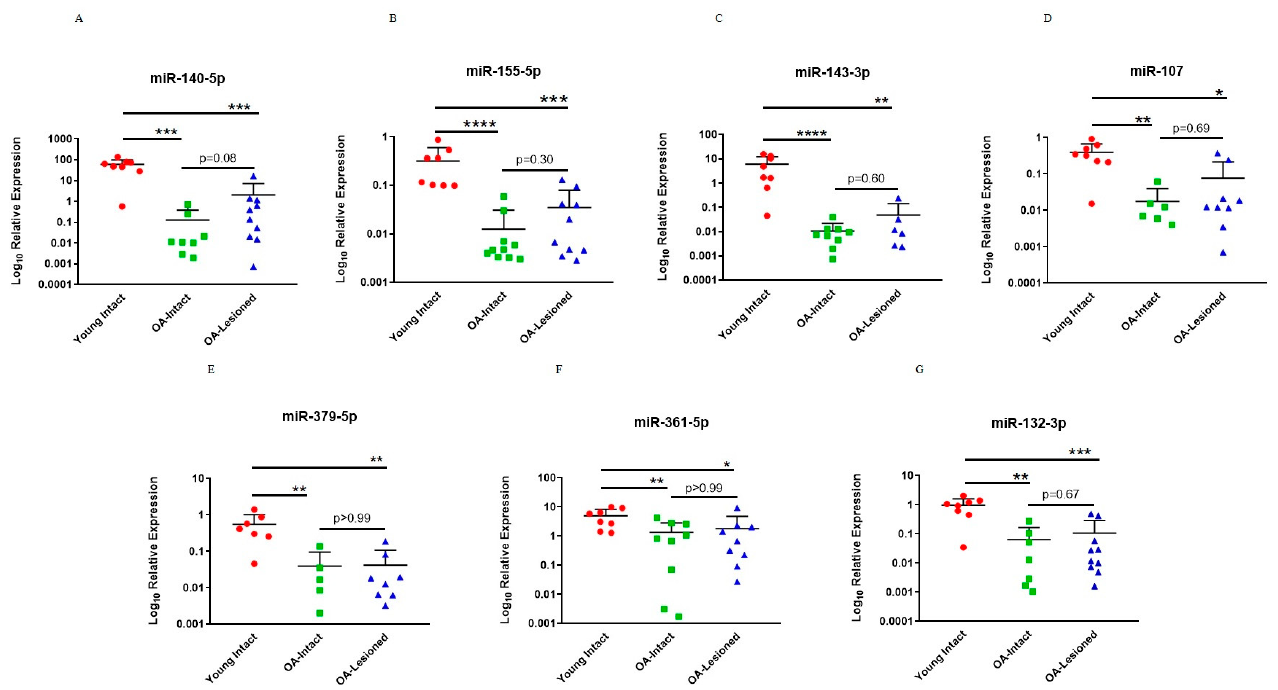
Figure 3. qPCR validation of selected DE miRNAs from the dependent cohort. Seven miRNAs; ( A ) miR-140-5p, ( B ) miR-155-5p, ( C ) miR-143-3p, ( D ) miR-107, ( E ) miR-379-5p, ( F ) miR-361-5p and ( G ) miR-132-3p, which were DE in microarray analysis were selected for validation with qPCR in the same samples. n = 5–10 samples/group. Y axis represents log-transformed expression relative to miR-6786-5p. Statistical analysis was undertaken using a Mann–Whitney test in GraphPad Prism (Version 8.0.1). Data are represented as mean + SD. Red: Young group, Green: OA-Intact group, Blue: OA-Lesioned group. p values < 0.05 were considered significant. *: p < 0.05, **: p < 0.01, ***: p < 0.001, ****: p <